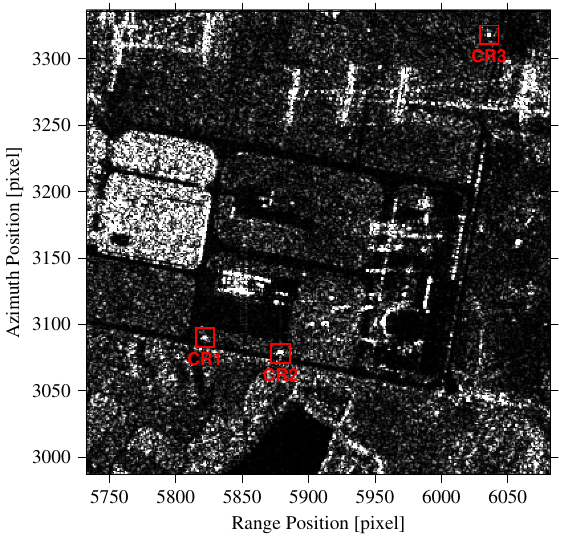
Figure 3. SAR average intensity map with three CRs highlighted in red box.